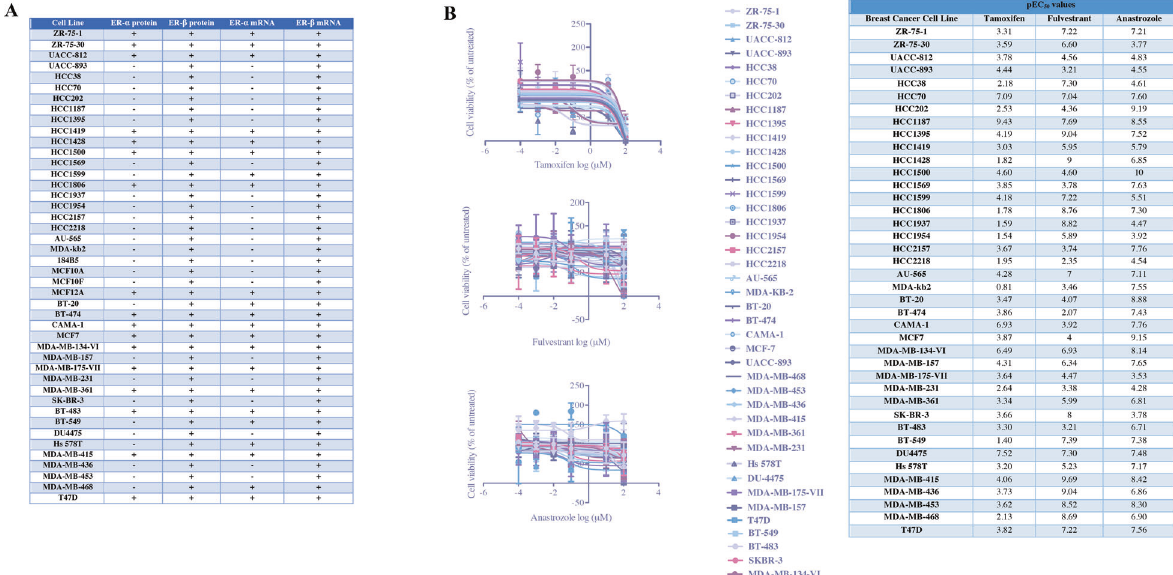
Fig. 1 ER- α and ER- β expression pro fi les and dose-response curves of tamoxifen, fulvestrant, and anastrozole in ATCC breast cancer cell line panel. A mRNA and protein expression status of ER- α /- β in breast cancer cells and normal breast epithelial cells were determined by using one-step RT-qPCR and immunoblotting, respectively. B Breast cancer cells were exposed to tamoxifen, fulvestrant, and anastrozole for 48 h and cell viability was evaluated by CellTiter-Glo assay (mean ± SEM, n = 3). EC 50 values were determined by nonlinear regression analysis and pEC 50 values were